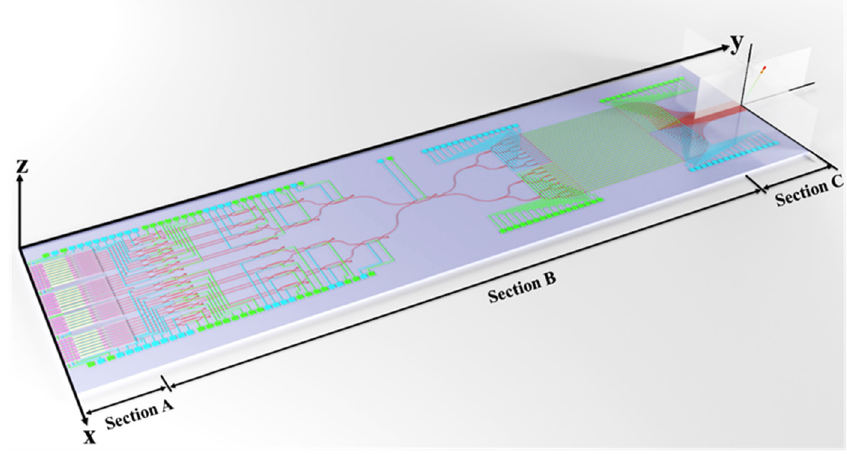
Figure 1. Schematic diagram of the proposed OPA showing the main parts.